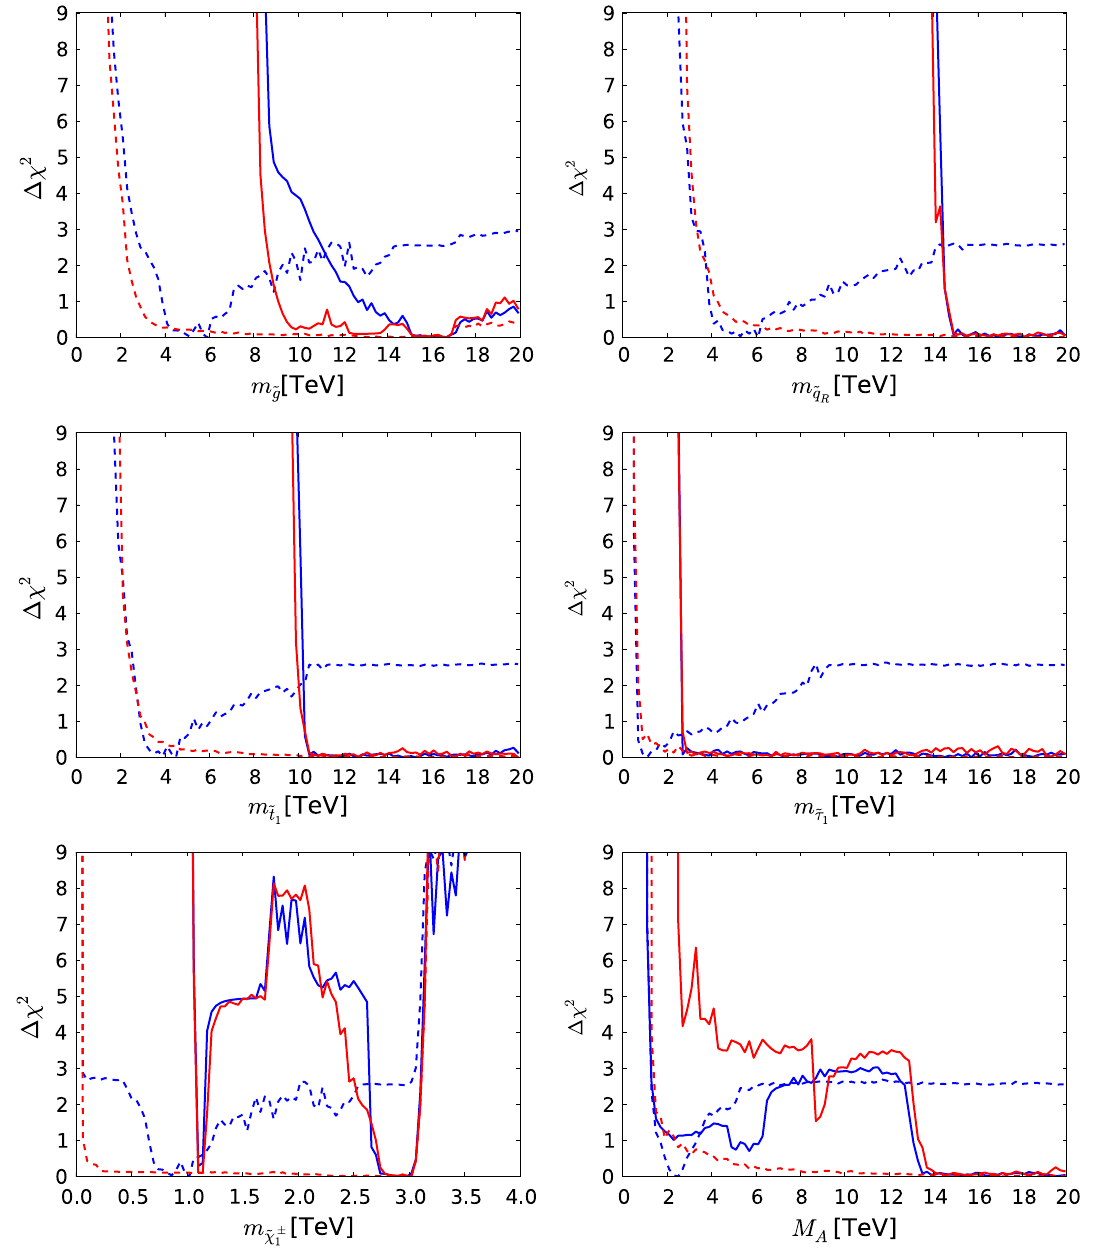
, m ˜ τ , m and M A . We show curves with both (cid:4) ˜ χ 0 ˜ χ ± 1 1 1 μ > 0 and μ < 0 cases ( blue and red ,